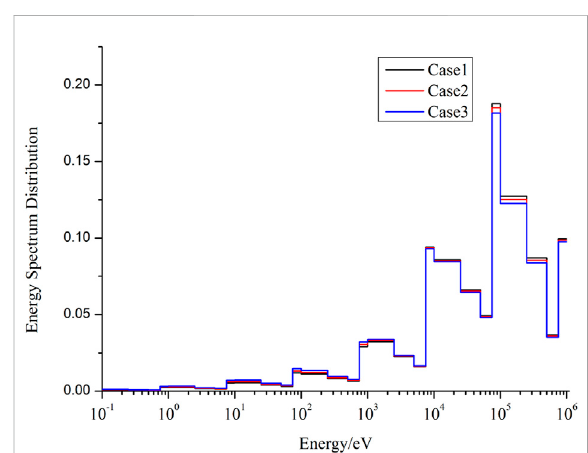
FIGURE 11 Energy spectrum results on the beginning of life of the pitch- to-diameter ratio